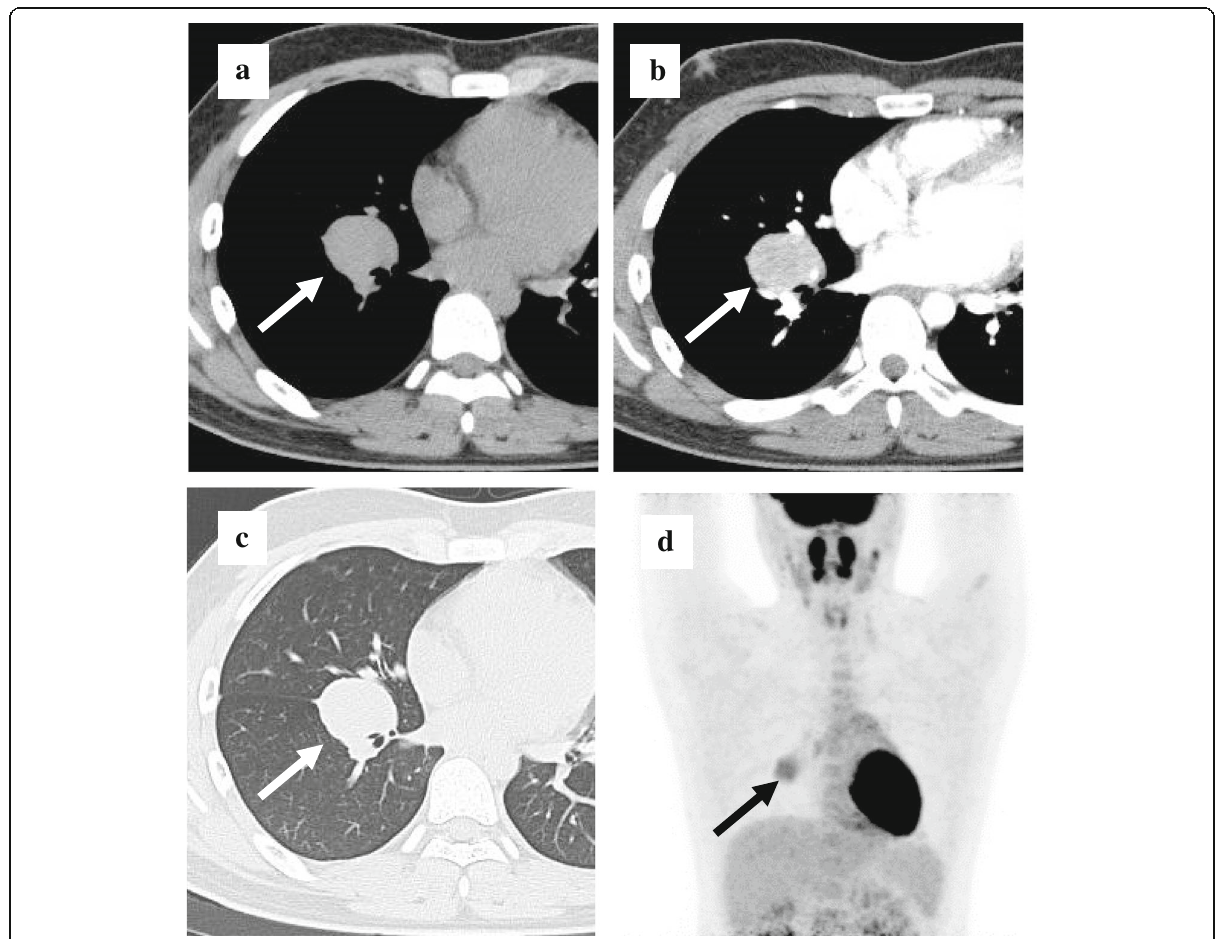
Fig. 1 Radiological findings. a Non-enhanced chest CT of mediastinal condition showed a 35-mm mass in the right pulmonary hilum (arrow). b In enhanced chest CT of mediastinal condition, the tumor was strongly enhanced in the early phase (arrow). c In non- enhanced chest CT of lung field condition, abnormal findings were not found in the lung field. d FDG-PET scan showed accumulation only in the mass